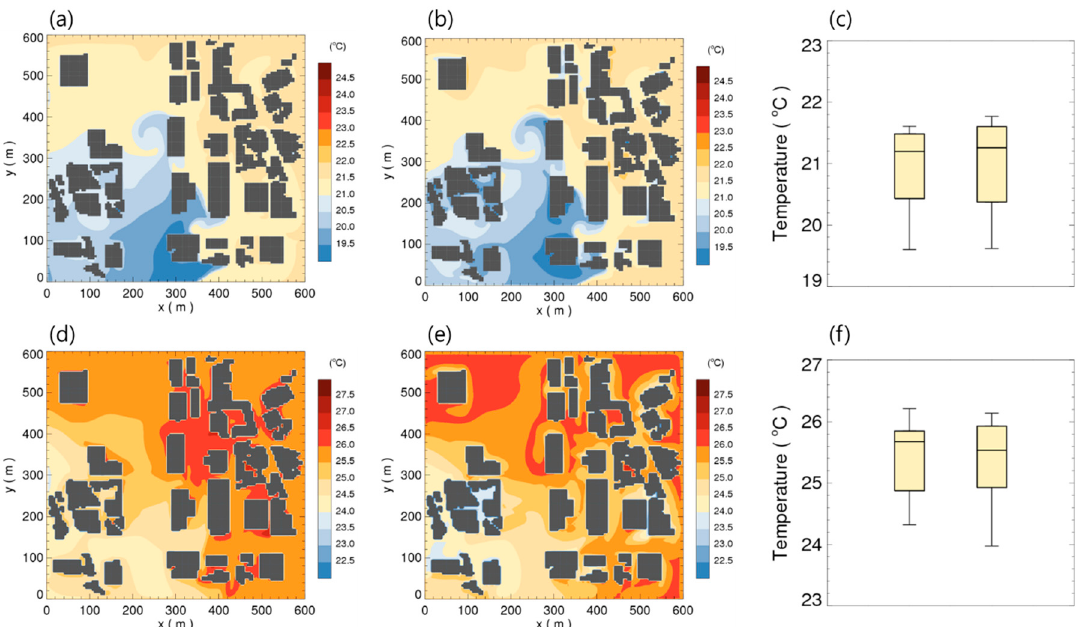
Figure 13. The spatial distributions of the pedestrian-level air temperatures simulated with ( a, d ) homogeneous surface heating, ( b, e ) heterogeneous surface heating, and ( c, f ) their difference at 10 LST (upper panels) and 14 LST (lower panels).